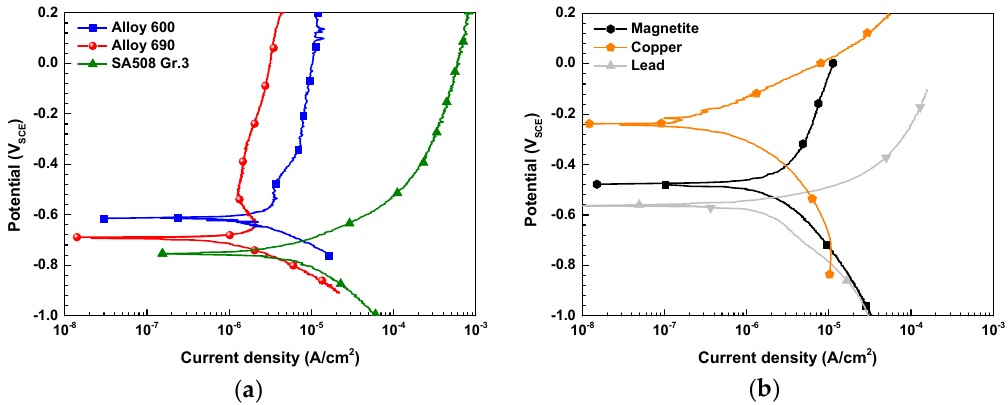
Figure 7. Potentiodynamic polarization curves of the SG materials and the corrosion products in alkaline solution at 80 °C: ( a ) the SG materials and ( b ) the corrosion products. Table 5. Measured values of anodic and cathodic Tafel constants β a and β c , corrosion potential E corr , corrosion current density i corr obtained from potentiodynamic polarization curves, polarization resistance R p , and corrosion current density i corr. pr obtained from polarization resistance test.